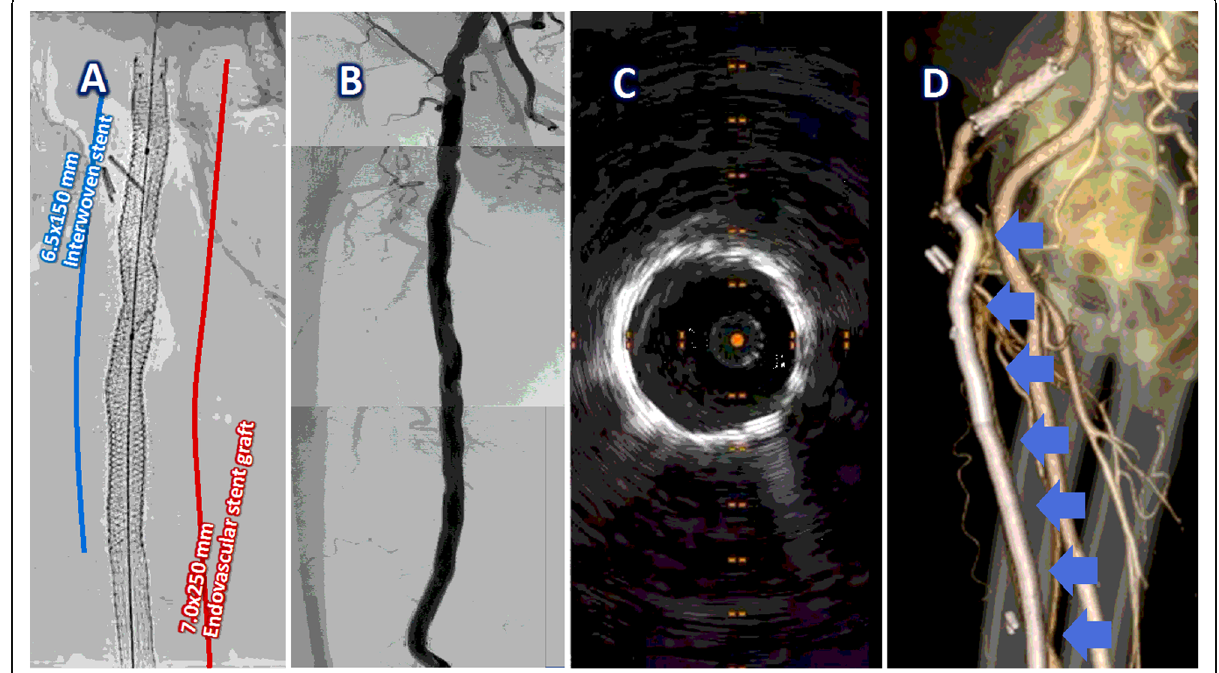
Fig. 3 Final results and computed tomography angiogram at the 12-month follow-up. A . The lesion was fully covered with a 7.0 × 250-mm endovascular stent graft (red line), and a 6.5 × 150-mm interwoven stent (blue line) was implanted to resist recoil and extrinsic compression. B . Final angiogram demonstrates a restored blood flow. C . Intravascular ultrasound showed symmetrically expanded scaffolds. D . Computed tomography angiogram found patency (blue arrows) one year after the